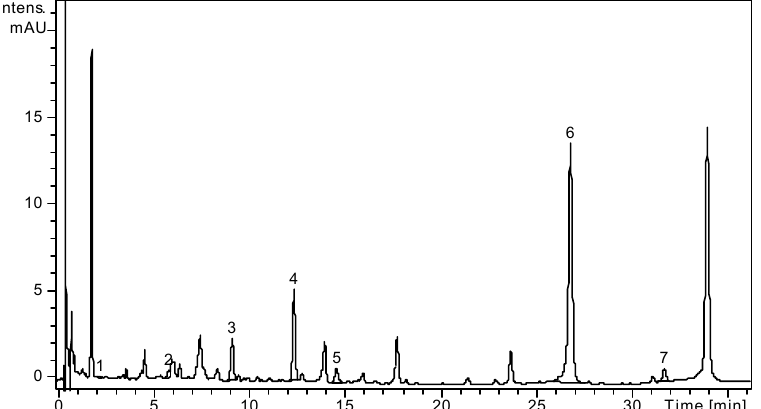
Figure 2. HPLC chromatogram of a hydrolysed sample of A. senescens subsp. montanum (A2